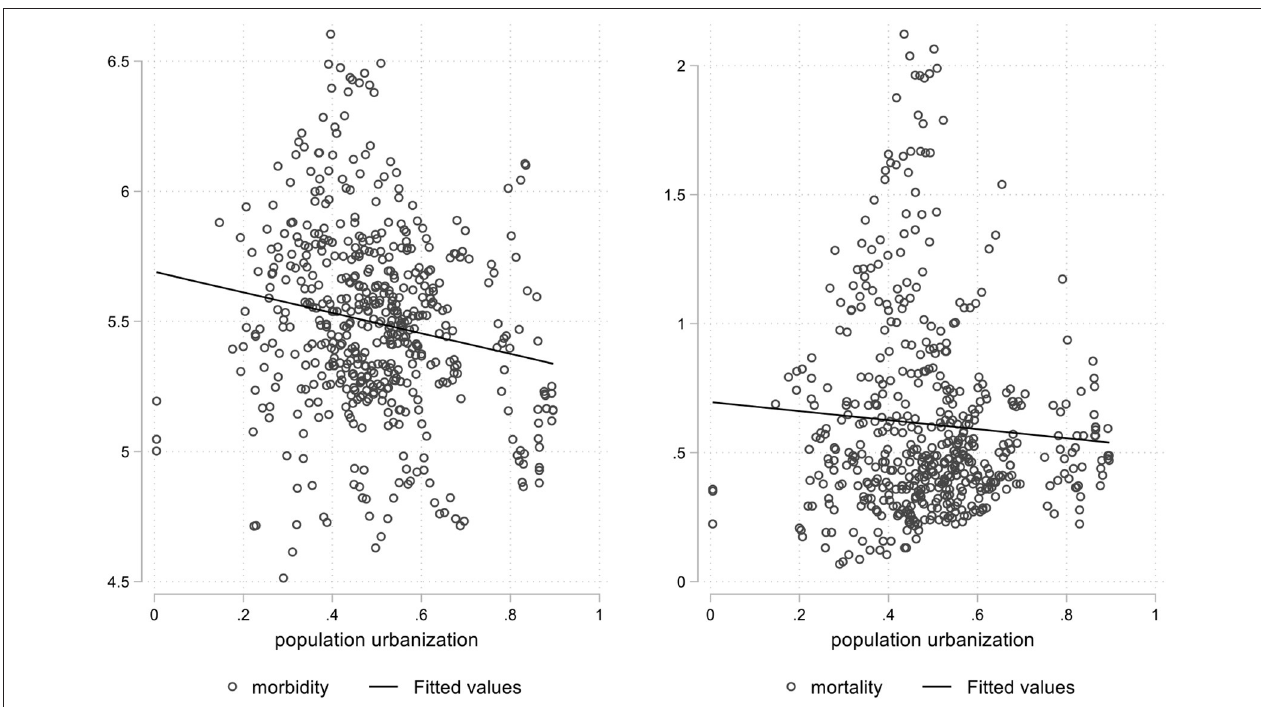
FIGURE 1 | Fitting relationships between population urbanization and the morbidity and mortality.